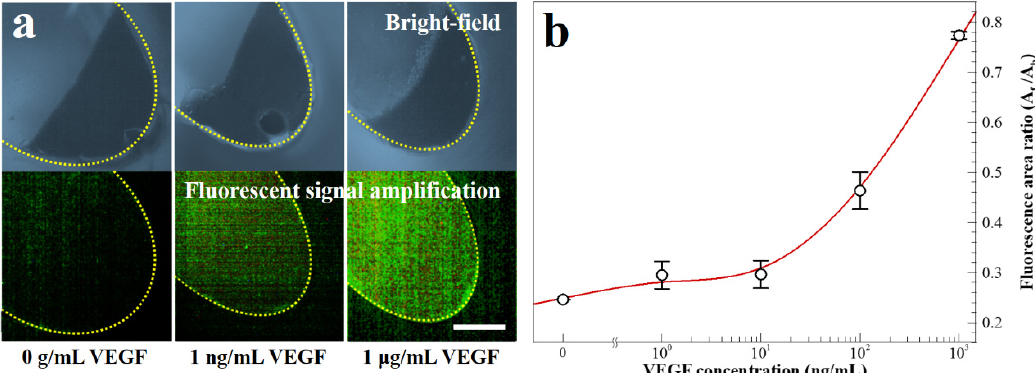
Figure 7. ( a ) Bright-field and fluorescence images for fluorescent dye-coupled microbeads, with VEGF concentrations of 0 g mL − 1 , 1 ng mL − 1 , and 1 µ g mL − 1 (scale bar = 100 µ m). ( b ) Fluorescence intensity with varying VEGF concentrations.